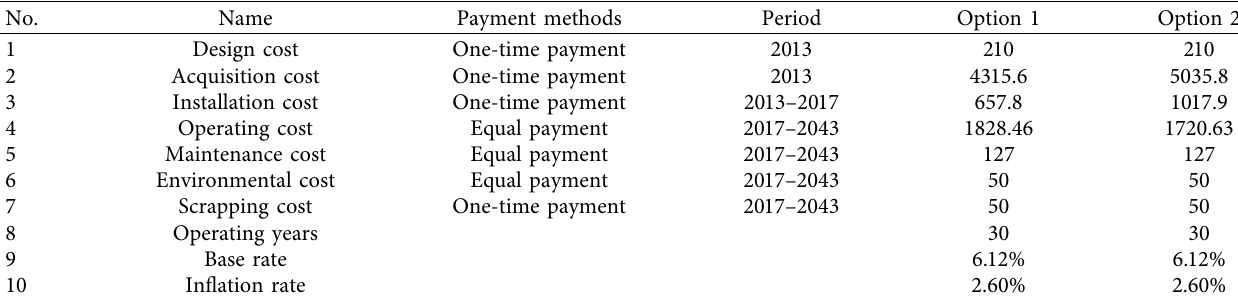
Table 7: Table of cost considering the time value of money (million